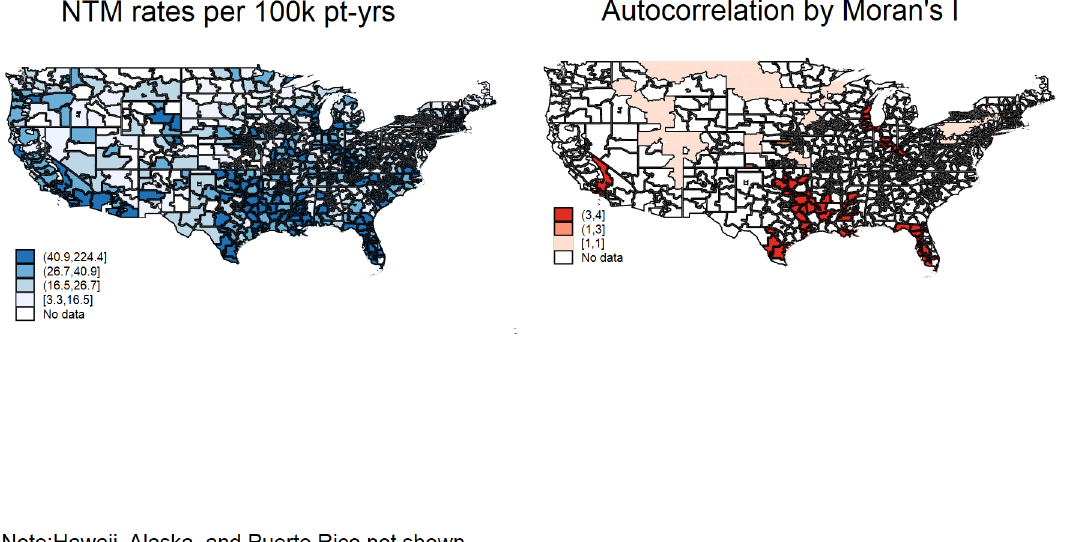
Fig 3. United States Veterans Health System regions grouped by first three digits of zip code. Incidence rates area denominated by 100,000 patient-years. Moran’s I measures the spatial correlation of a region with adjacent regions; positive correlations are > 1, while negative correlations are < 1. Reprinted from Esri 1 ArcGIS Online 1 under a CC BY license, with permission from Environmental Systems Research Institute, Inc., original copyright